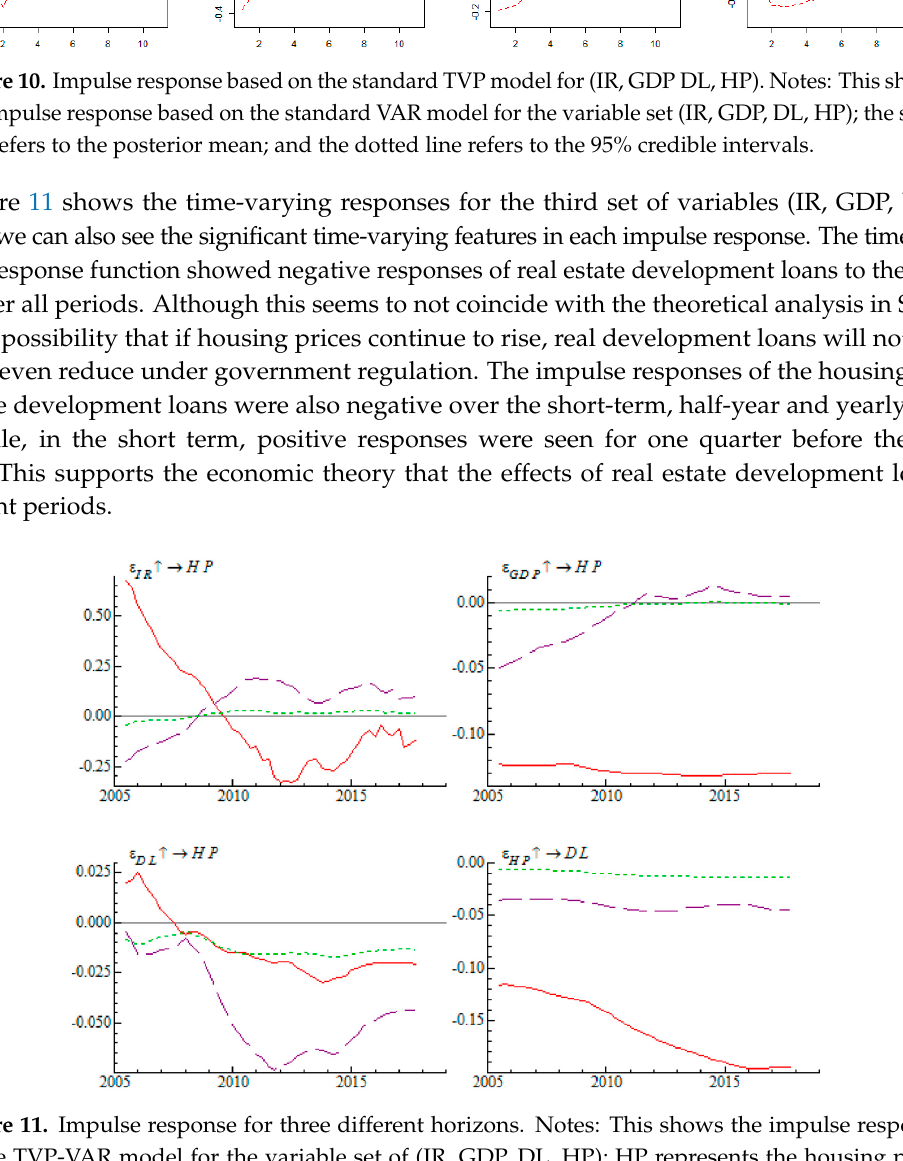
Figure 10. Impulse response based on the standard TVP model for (IR, GDP DL, HP). Notes: This shows the impulse response based on the standard VAR model for the variable set (IR, GDP, DL, HP); the solid line refers to the posterior mean; and the dotted line refers to the 95% credible intervals.